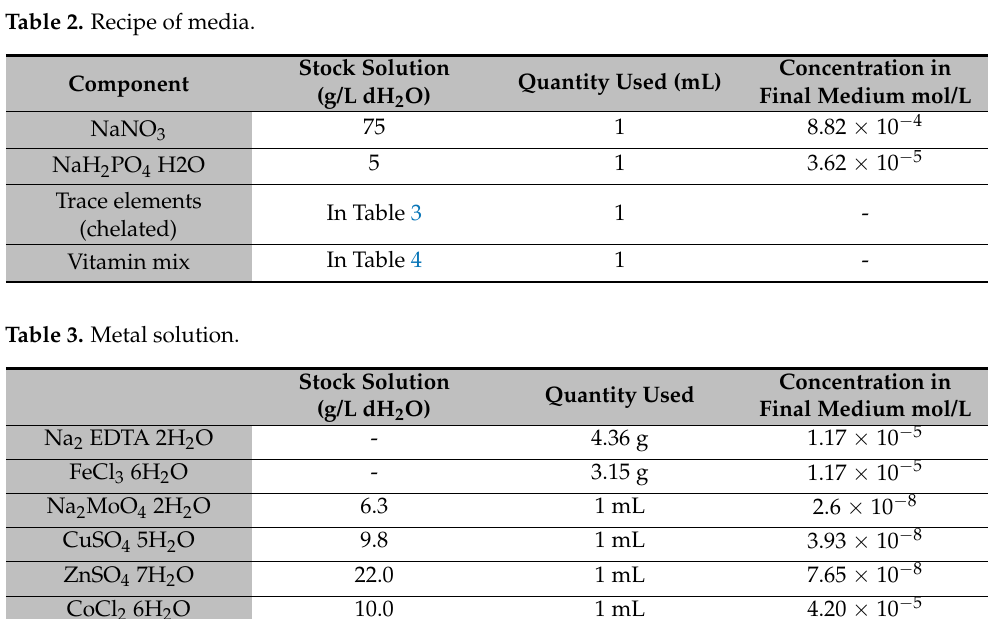
Table 2. Recipe of media.